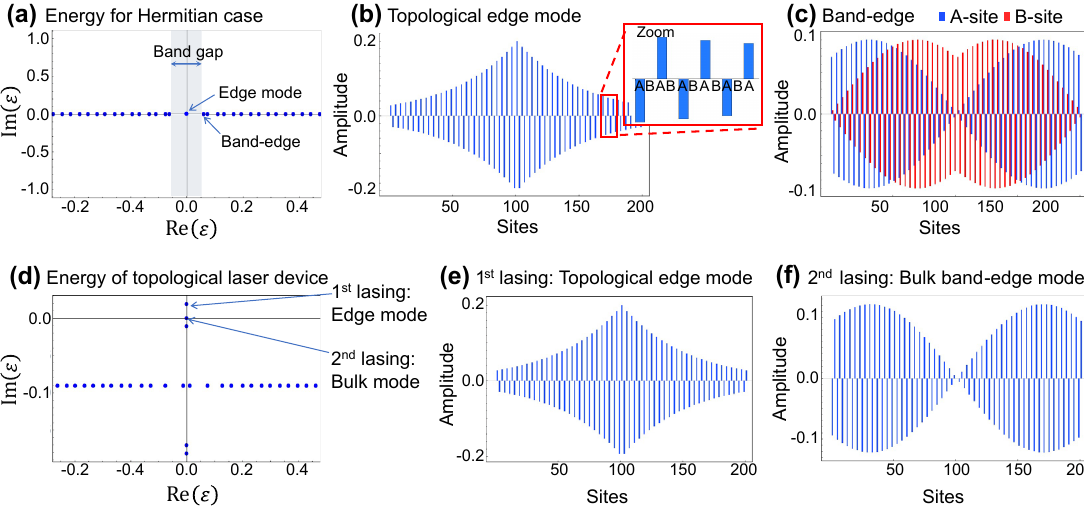
Figure 2: Eigenstates of the edge mode and band-edge bulk mode. (a) The eigenenergies 𝜀 in the complex energy plane for the Hermitian case, zoomed around origin. (b) Spatial profile of the topological edge mode. The inset shows that the edge mode has non-zero amplitudes only on A -sites. (c) Spatial profile of the band-edge bulk mode for comparison. For (a)–(c), the parameters used are 𝜅 complex energy plane for the topological laser system with gain and loss, zoomed around origin. (e) Spatial profile of the first lasing mode, i.e., topological edge mode. (f) Spatial profile of the second lasing mode stemming from an amplified bulk mode, exhibiting non-zero amplitudes only on A -sites. For (d)–(f), the parameters used are 𝜅 n tri = 100 and n topo = 101. In ((b), (c), (e) and (f)), blue and red bars indicate the amplitudes on A -site and B -site,